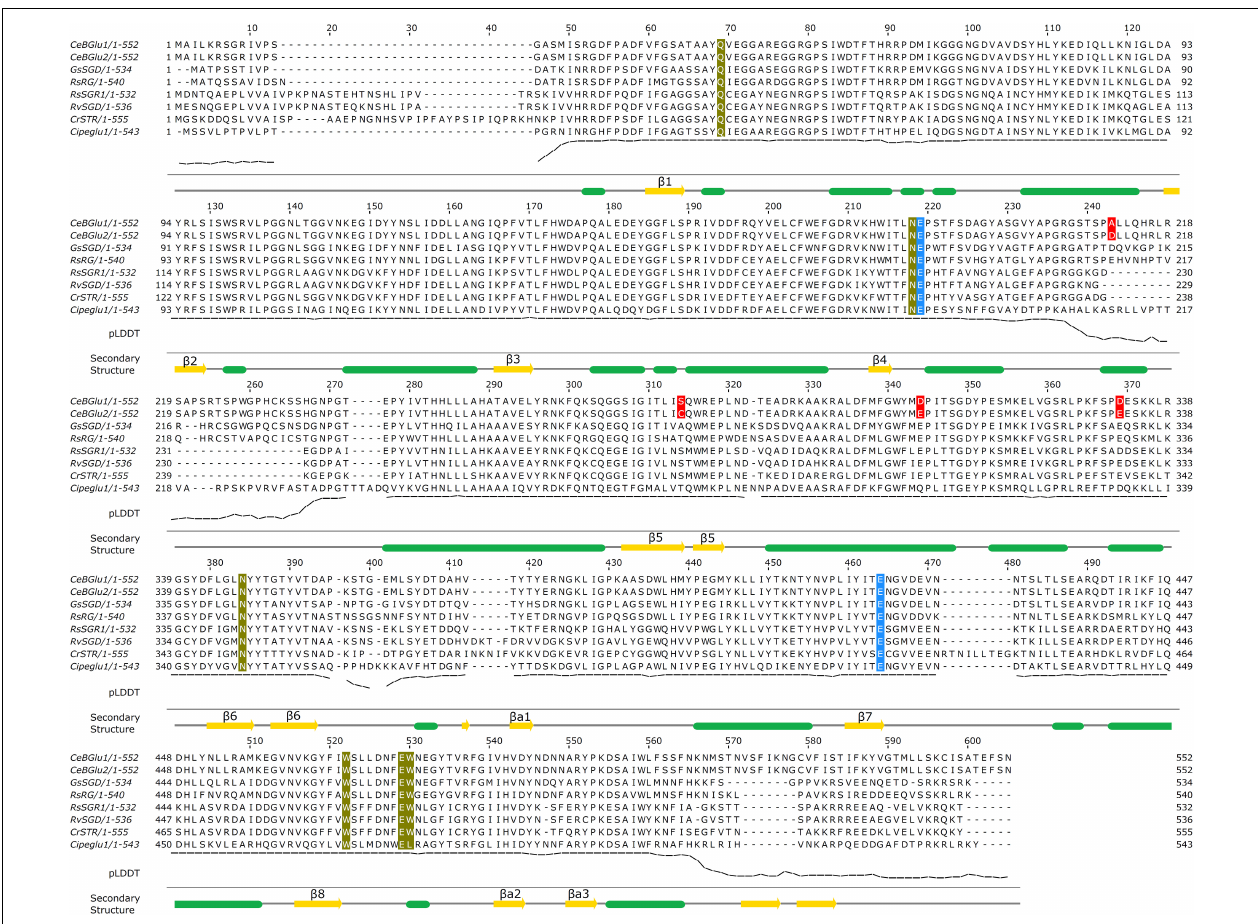
FIGURE 3 | Multiple sequence alignment of Ce BGlu1 and Ce BGlu2 with β -glucosidases from species belonging to the Gentianales order. The two Glu catalytic residues are colored blue, active site residues involved in sugar specificity are colored olive, and residues differing between Ce BGlu1 and Ce BGlu2 are indicated in red. The secondary structure diagram shown below the alignment is based on the Ce BGlu1 AlphaFold model. The pLDDT score (predicted lDDT-C α ) shown below the alignment is a per-residue estimate of AlphaFold confidence on a scale from 0 to 100. Lower values are often associated with disordered regions. It is shown for Ce BGlu1 AlphaFold model. RsRG sequence corresponds to the PDB:3U5Y glucosidase from Rauvolfia